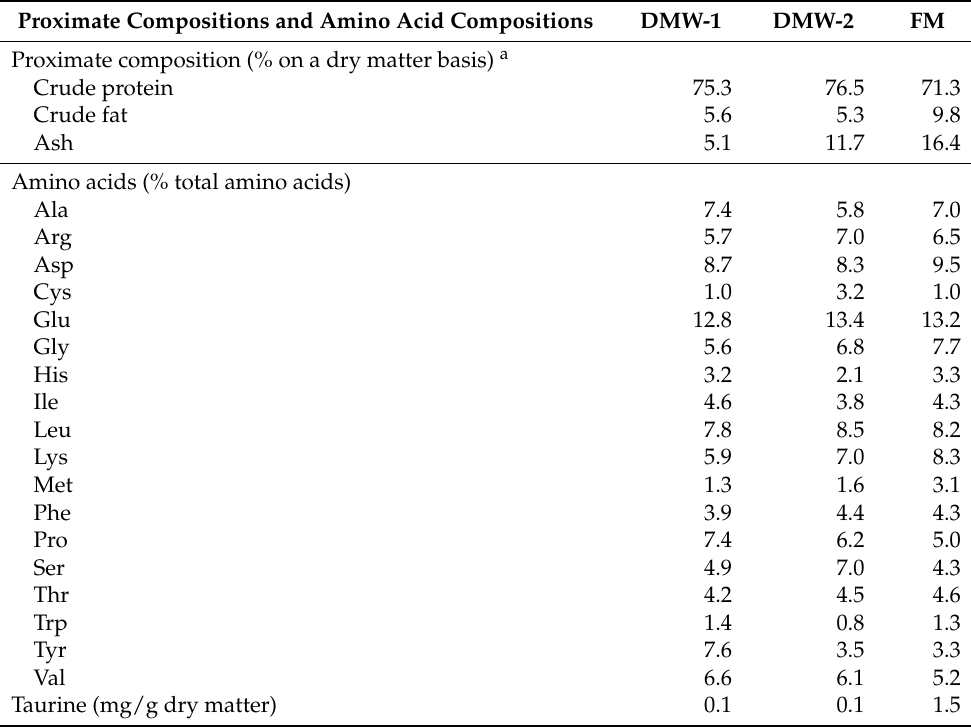
Abbreviations: DMW-1, defatted mealworm larvae with hexane and ethanol solvent; DMW-2, defatted mealworm larvae produced in Shangdong, China, obtained from Shintoa Corporation. FM, fish meal obtained from Shintoa